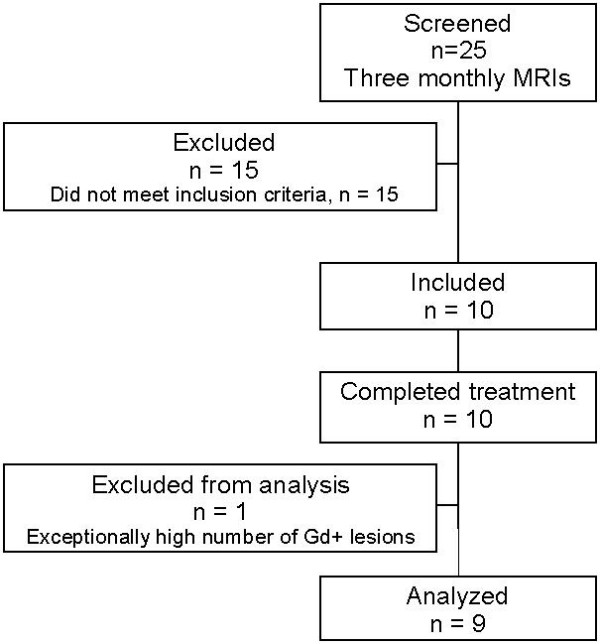
Study flow chart